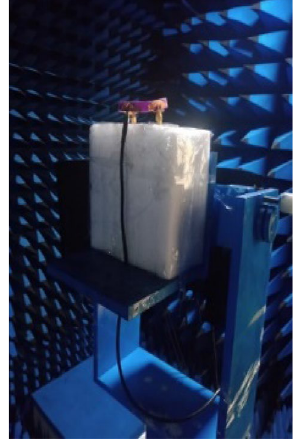
Figure 12. Anechoic chamber measurement setup.